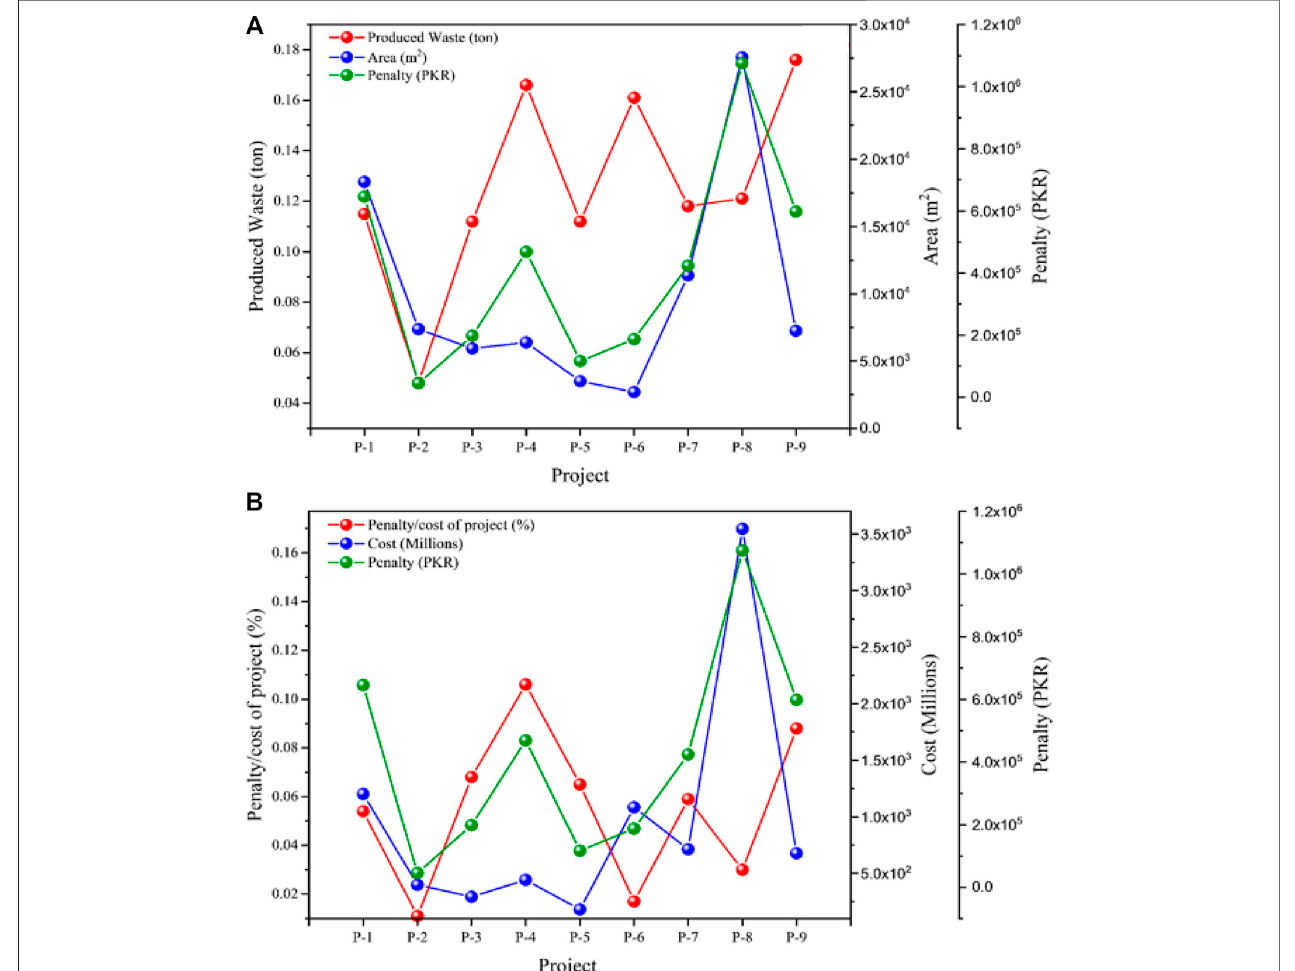
Frontiers in Environmental Science |